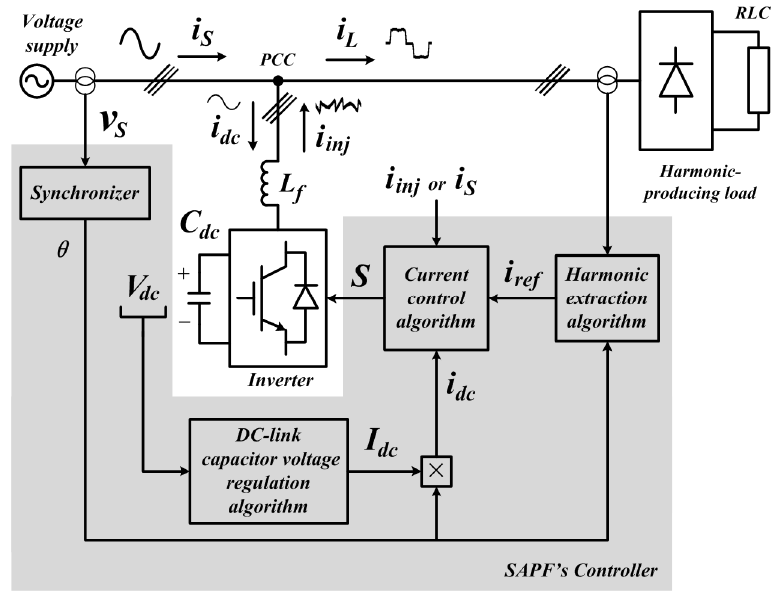
Figure 1. Typical circuit connection of an inverter-based shunt active power filter (SAPF) with control algorithms.